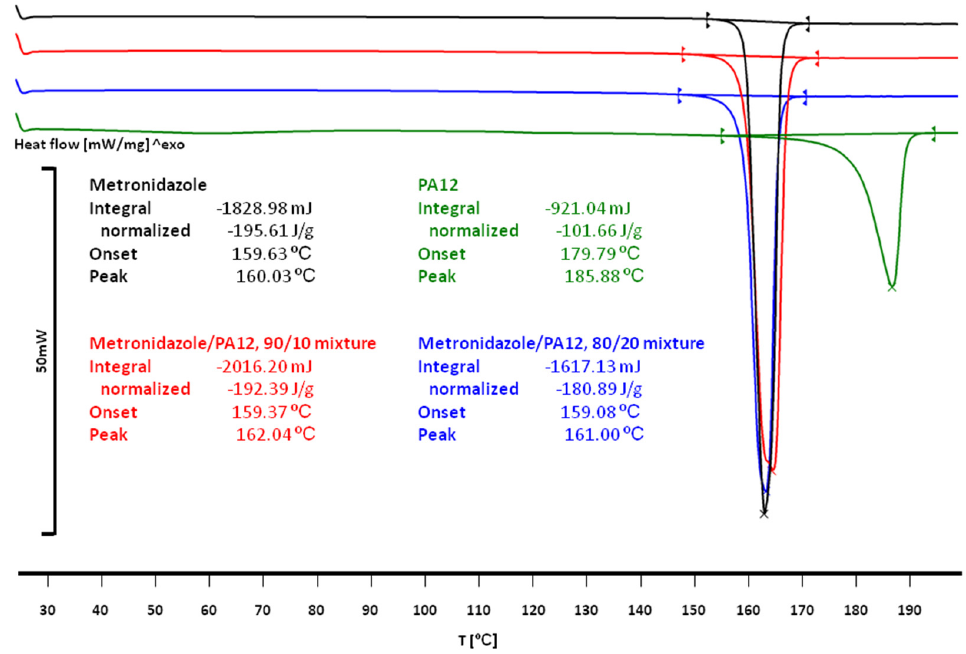
Figure 3. DSC curves of pure Met, PA12 and physical mixtures Met/PA12 (90/10 and